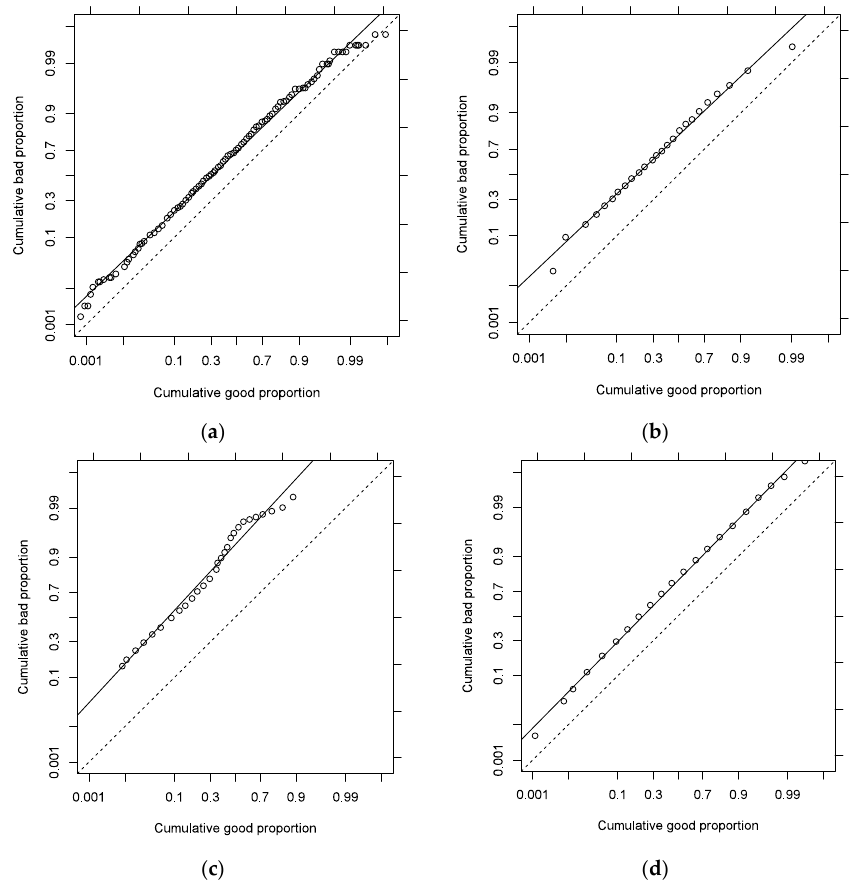
Figure 5. Empirical ROC curves on binormal plots. ( a ) A1 model; ( b ) Data from Ř ezá č and Ř ezá č (2011); ( c ) Data from Tobback and Martens (2019); ( d ) C1 model. Table 3. ROC curve models—pros and cons.